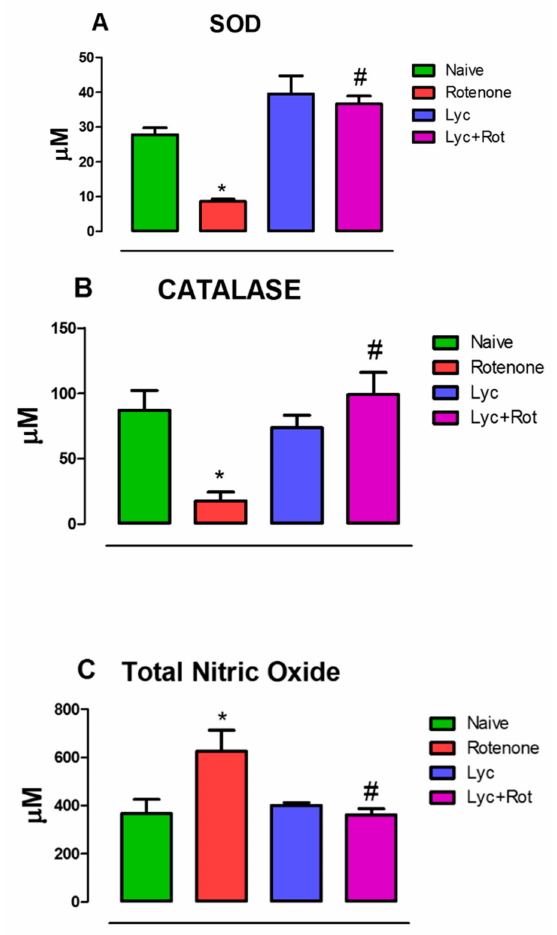
Figure 2. Evaluation of SOD, CAT and nitric oxide in experimental animals. Administration of rotenone-ameliorated brains vital antioxidant, SOD ( A ), CAT ( B ) with concomitant increase in total nitric oxide levels ( C ). Alternatively, Lyc treatment prevented nitric oxide production and reversed antioxidant loss. Values are expressed as mean ± SEM. * p < 0.05 compared to control, # p < 0.05 compared to rotenone treated